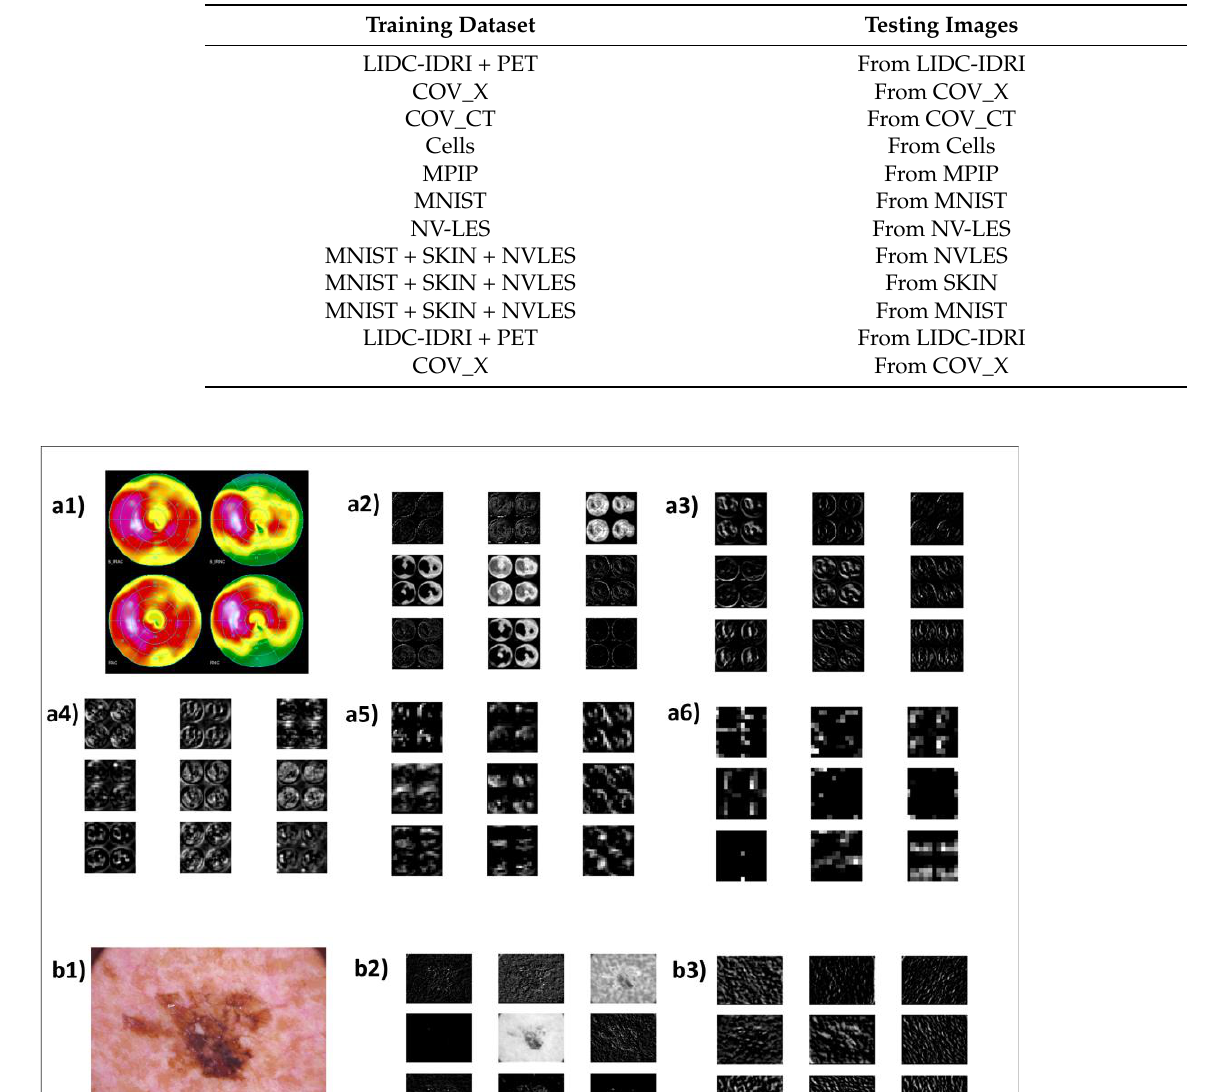
Table 12. The training dataset and the testing image of each visualised feature map group.